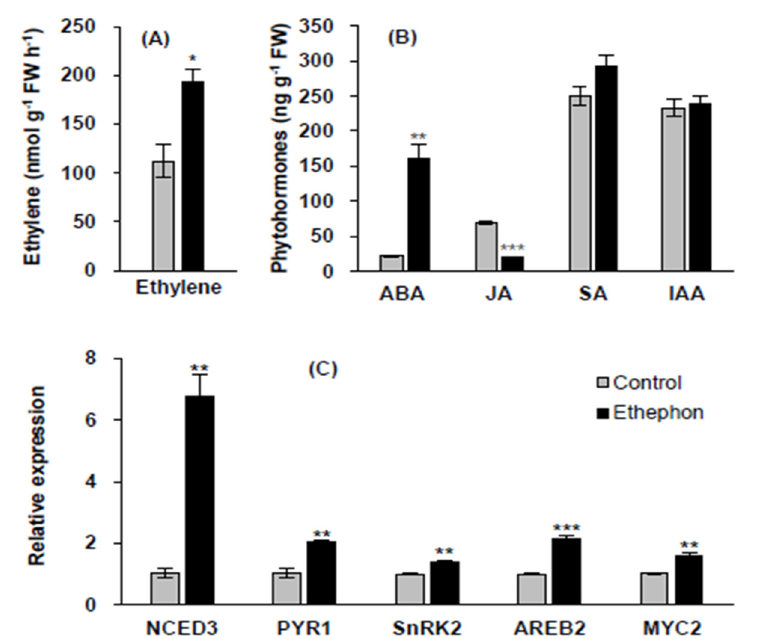
Figure 2. Ethylene content ( A ), phytohormone [abscisic acid (ABA), jasmonic acid (JA), salicylic acid (SA), indole-3-acetic acid (IAA)] content ( B ), and expression of ABA synthesis-related gene ( NCED3 ), ABA receptor gene ( PYR1 ), and ABA signaling-related genes ( SnRK2 , AREB2 , and MYC2 ) ( C ) in mature leaves in control or ethephon-treated plants for 10 days. Data are presented as mean ± SE ( n = 3). The qRT-PCR was performed in duplicate for each of the three independent biological samples. Significant differences between treatments are represented by * P < 0.05, ** P < 0.01, *** P < 0.001.